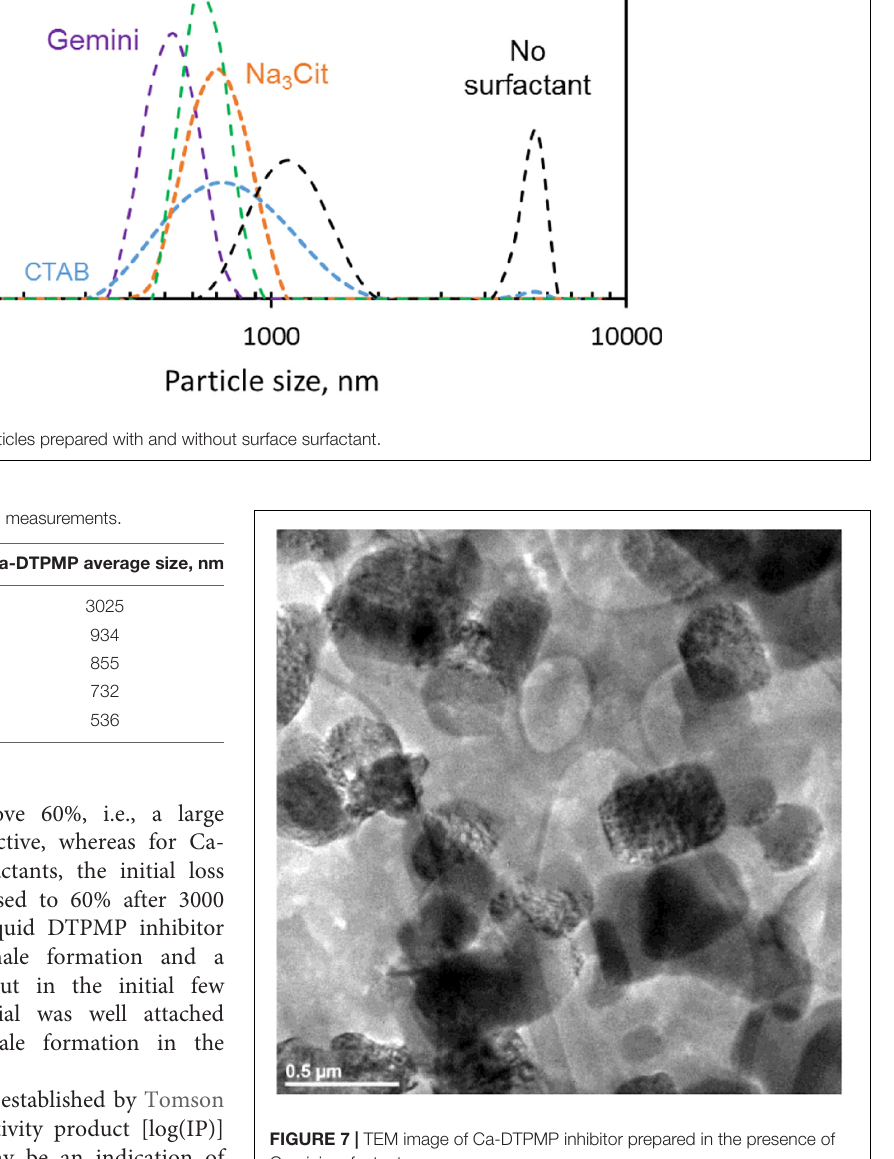
FIGURE 7 | TEM image of Ca-DTPMP inhibitor prepared in the presence of Gemini